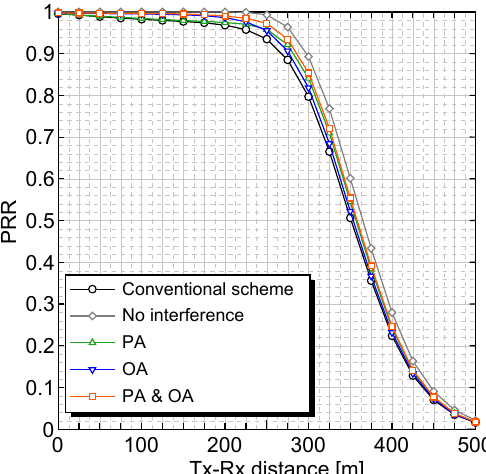
Figure 13. Effect of the PRR for generation pattern